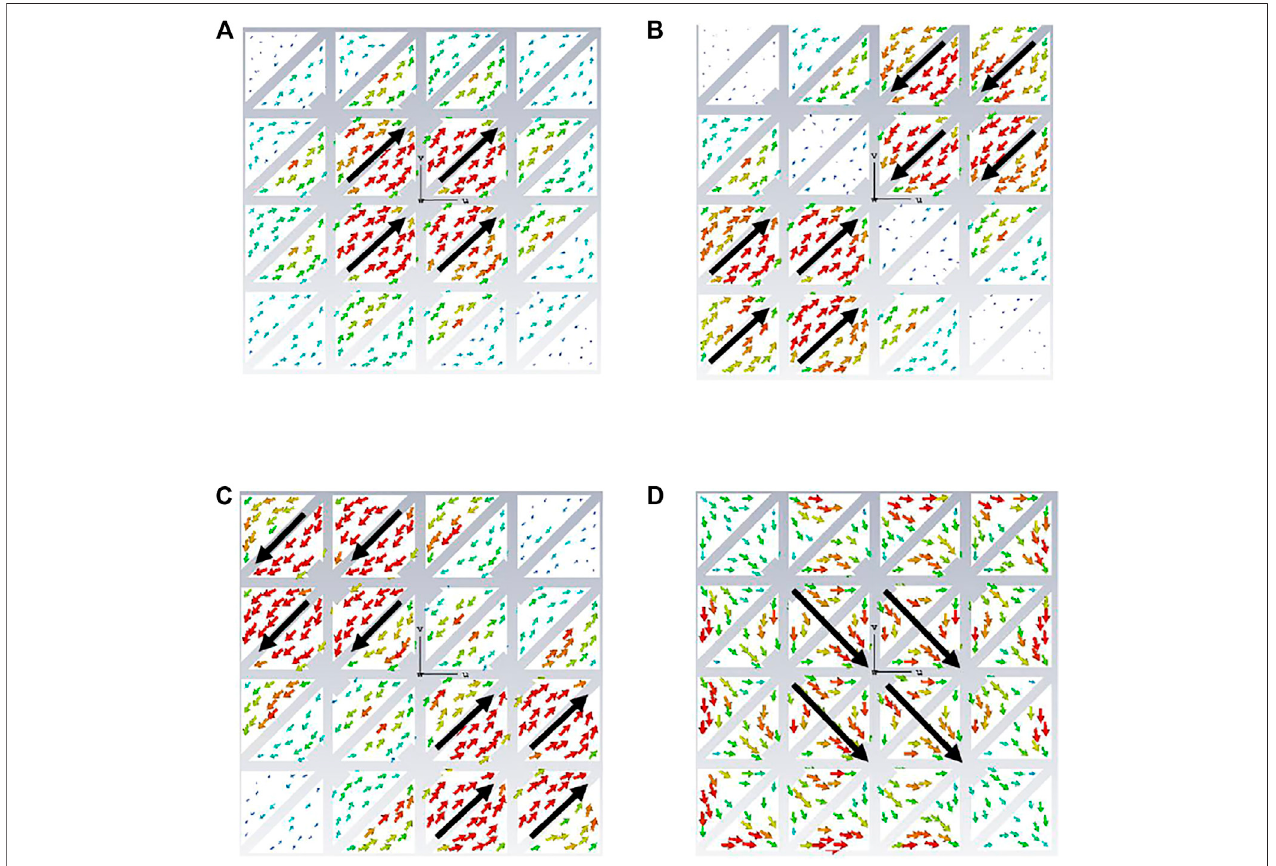
FIGURE 3 | Characteristic current of the metasurface at 5.8 GHz: (A) Mode 1; (B) Mode 2; (C) Mode 3; (D) Mode 4.